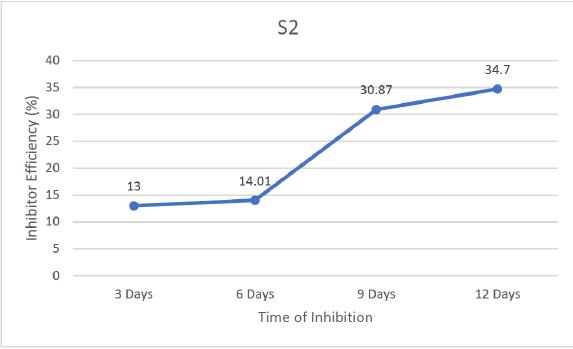
Figure 2: Plot of S2 (Inhibition eflciency (%) versus Time of inhibi- tion (days).